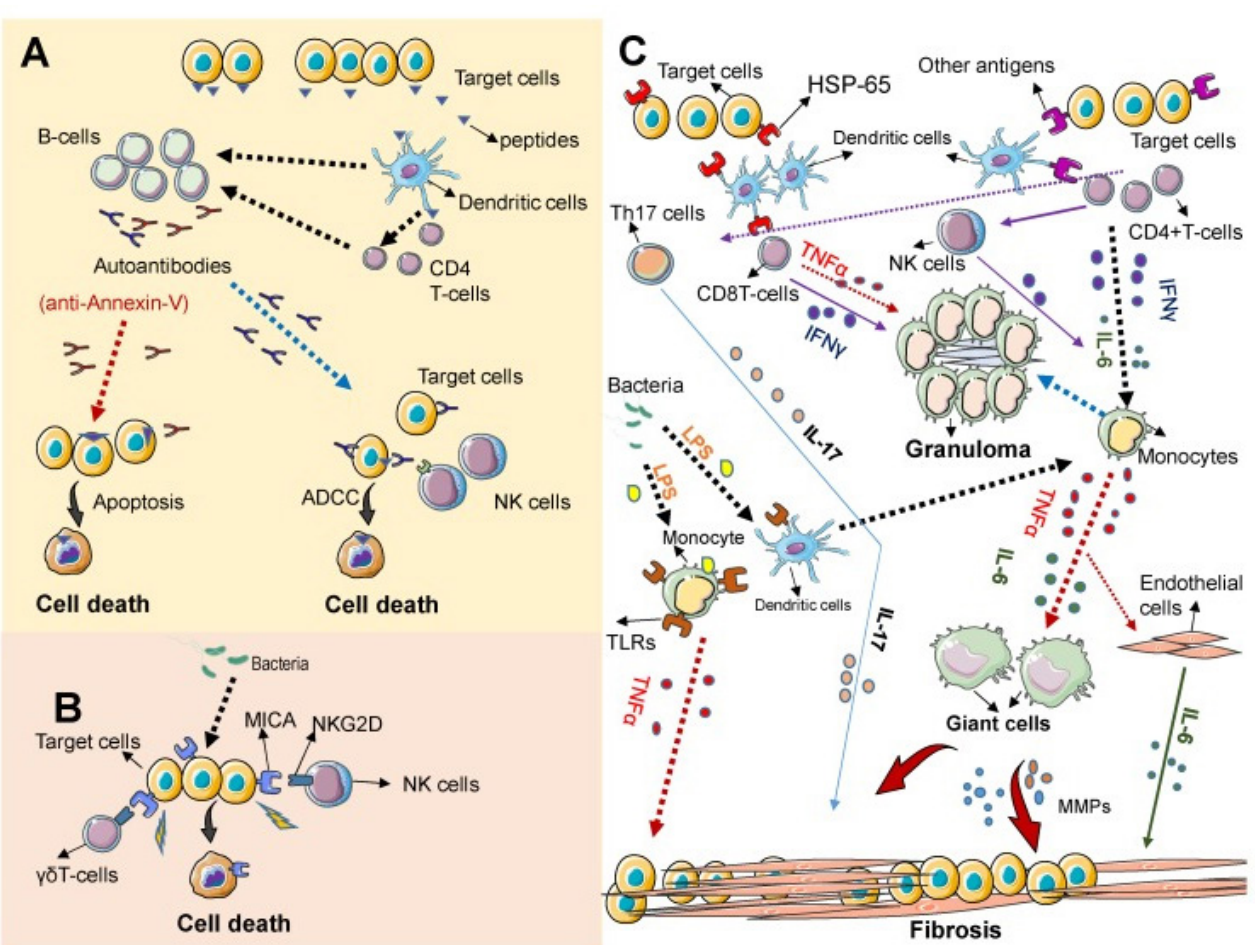
Fig. 2 – Current understanding of the pathogenesis of Takayasu’s arteritis[9]. ADCC=antibody-dependent cellular cytotoxicity; IFN-γ=interferon gamma; IL=interleukin; LPS=lipopolysaccharide; MMPs=matrix metalloproteinases; NK=natural killer; Th=T helper; TLRs=Toll-like receptors; TNFα=tumour necrosis factor alpha.